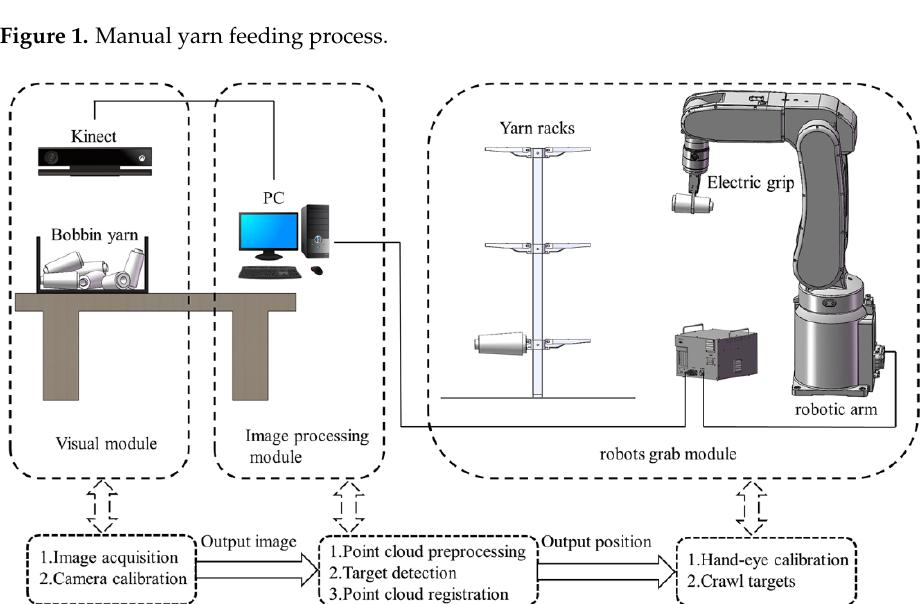
Figure 2. Developed a robot-based winding system.